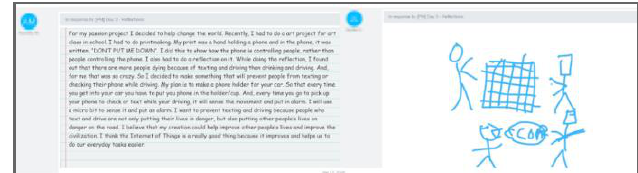
Figure 1. Examples of students’ multimodal digital design journal entries.